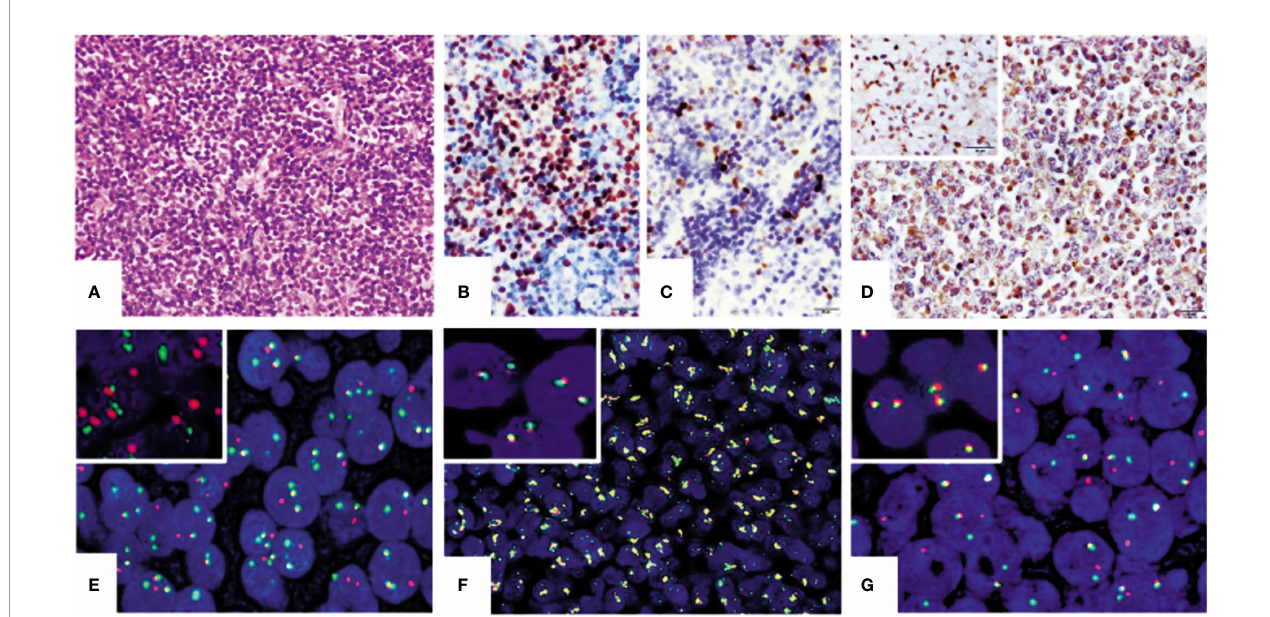
FIGURE 1 | Representation of IHC and FISH results of mantle cell lymphoma (MCL) tissues. (A) Morphology of MCL. Tumor cells were small to medium and were diffusely arranged in the mantle and paracortex area of the lymph node (HE ×400). Panels (B – D) are the results of IHC staining (×400) for cyclin D1 (B) , SOX11 (C) , and SAMHD1 in MCL tissues (D) and the insert in (D) is SAMHD1-positive control from clear cell kidney carcinoma. Panels (E – G) (×1,000) are examples of positive FISH tests of t(11;14) IGH/CCND1 translocation and cytokine gene rearrangement in MCL tissues. Panel (E) shows positive for t(14;18) IGH/CCND1 translocation and panel (G) is positive for CCND1 gene rearrangement. CCND2 gene ampli fi cation was also detected in one case of MCL (F) . Inserts in panels (E – G) are their corresponding negative controls.